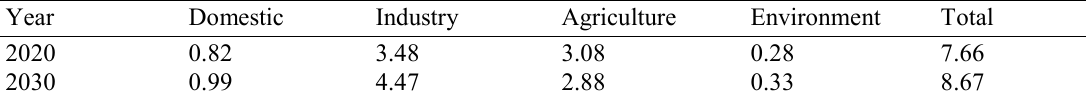
Table 1 Water demands forecasting in Chengdu (billion m 3 )